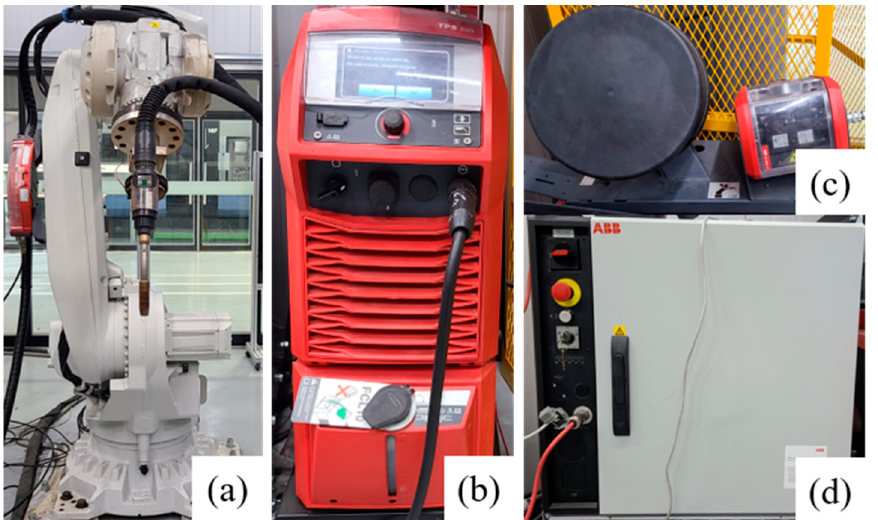
Figure 2. LMD experimental setup: ( a ) AM system; ( b ) powder feeder; ( c ) water chiller; and ( d ) 1 kW diode laser.